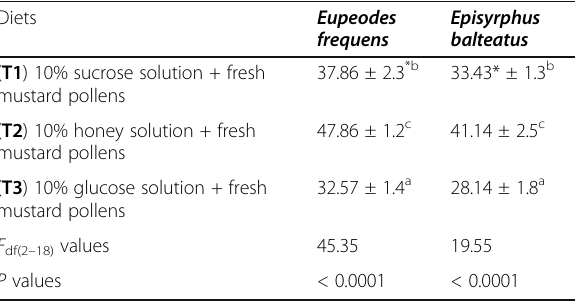
Table 4 Fecundity of Eupeodes frequens and Episyrphus balteatus on different diets Diets Eupeodes